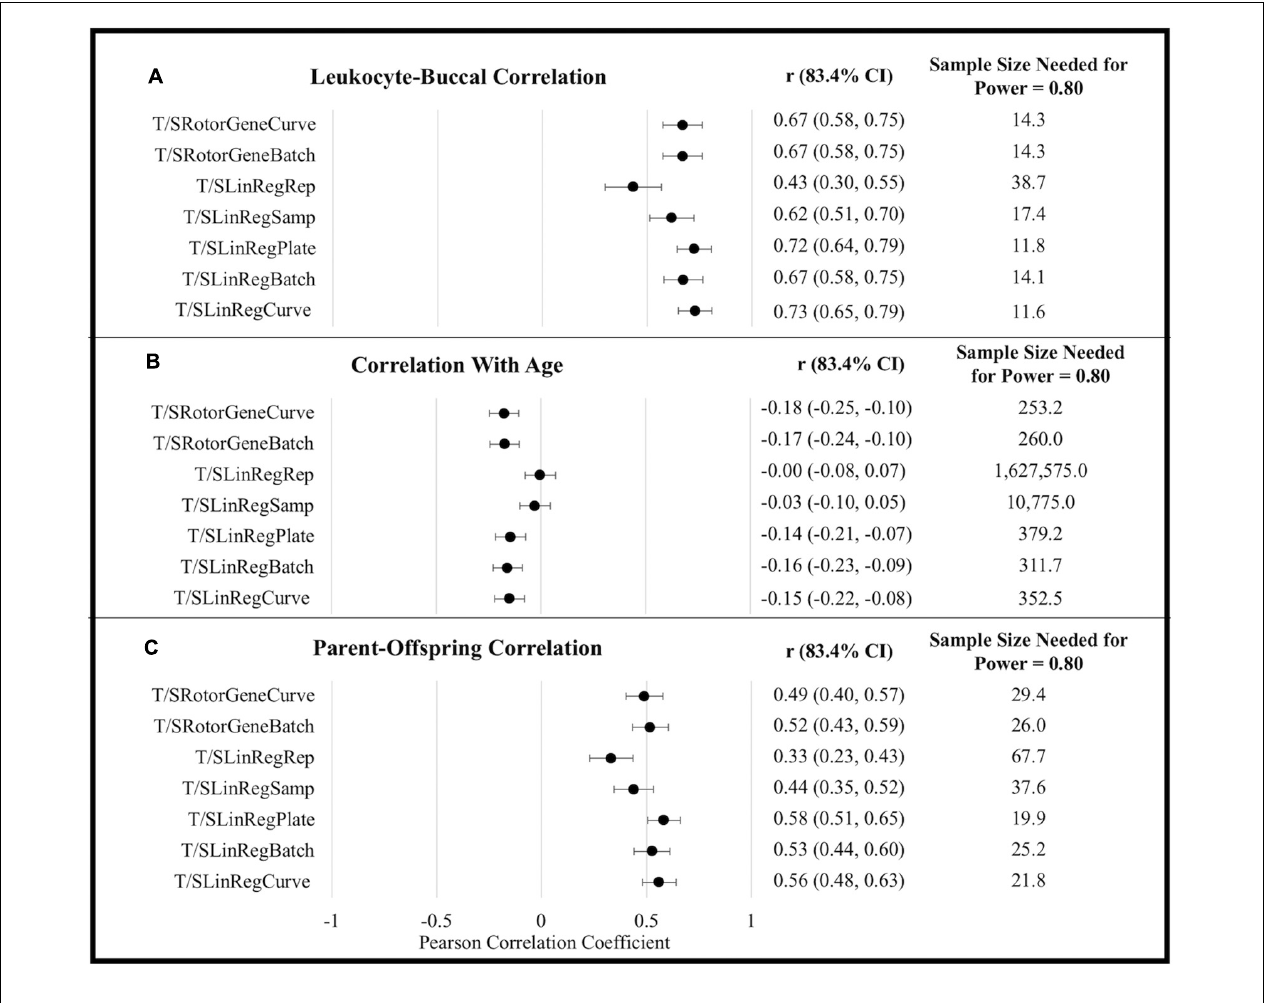
FIGURE 1 | External validity metrics for T/S ratios calculated using different amplification efficiencies. (A) Within-person Pearson correlation between leukocyte and buccal sample T/S ratios collected at the same time point. Correlations calculated controlling for sex and age. (B) Pearson correlations between age and T/S ratios. Correlations calculated controlling for sex and tissue (leukocyte/buccal). (C) Pearson correlation between T/S ratios of parent and offspring pairs. Correlations calculated controlling for offspring sex, parental age, offspring age, and tissue (leukocyte/buccal). CI, confidence